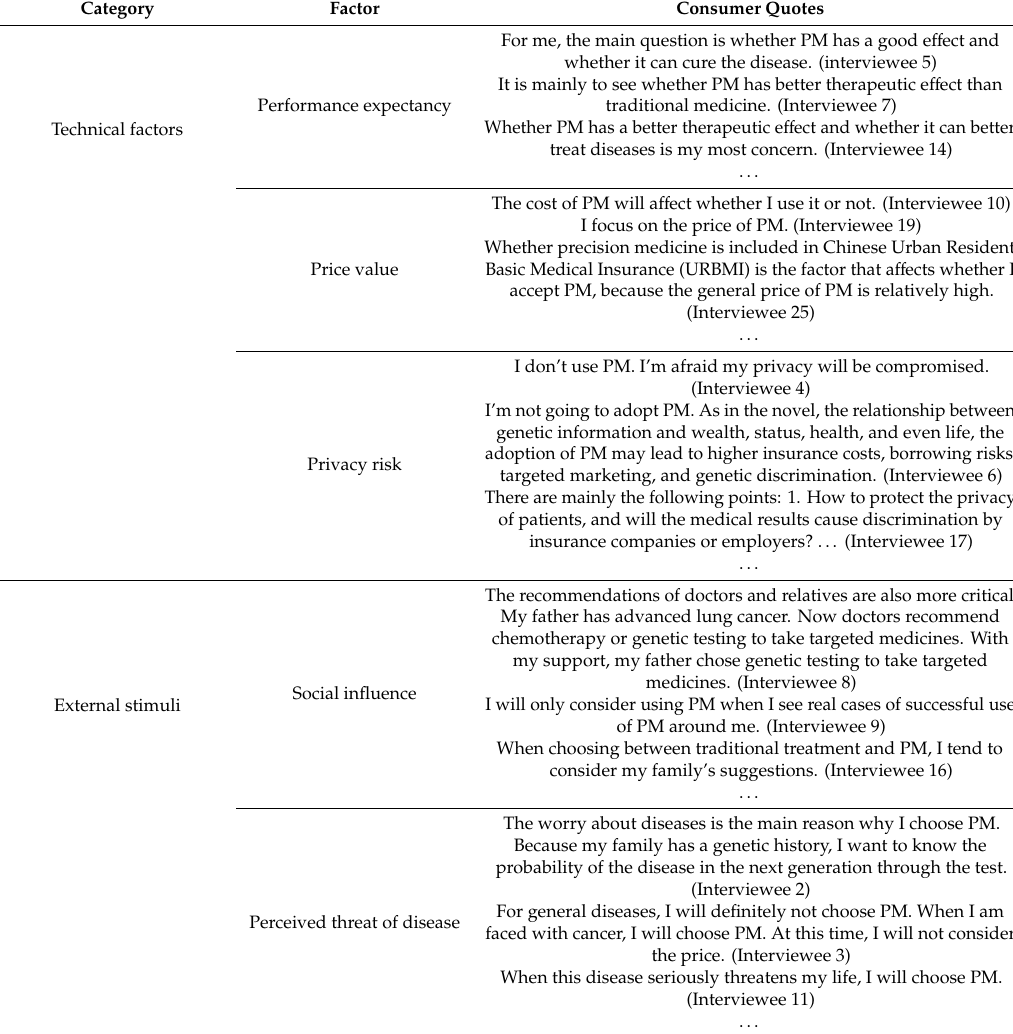
Table 1. Factors influencing the adoption of PM: consumer supporting